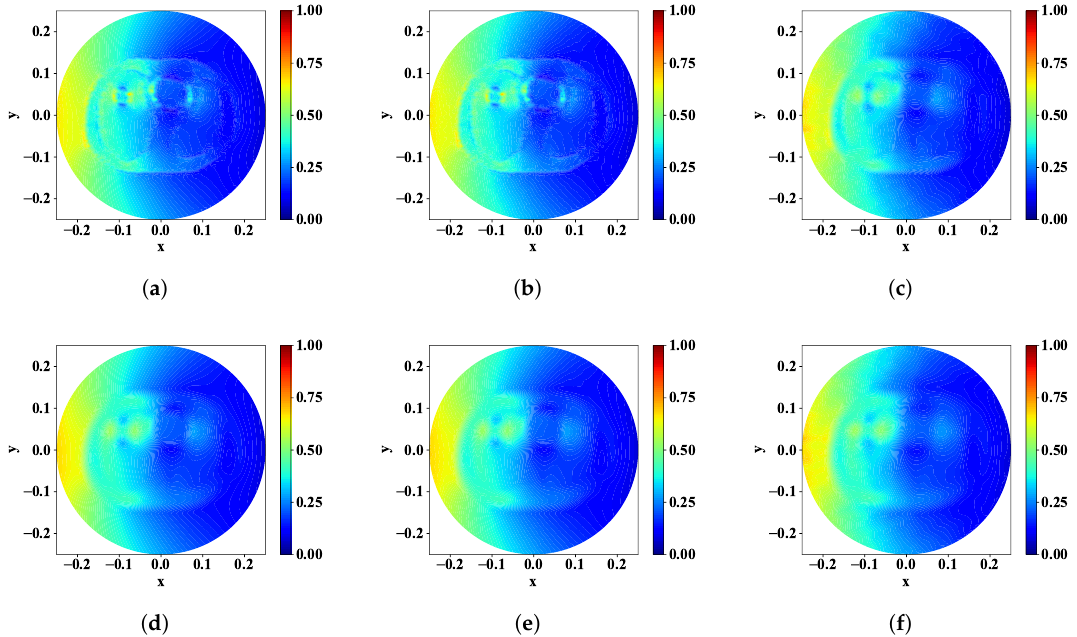
Figure 16. The power density corresponding to heart–lung model (top row) and smooth–heart–lung model (bottom row) at the iteration step where the minimum relative error achieved. ( a , d ) for SNR = ∞ , ( b , e ) for SNR = 40 dB, ( c , f ) for SNR = 20